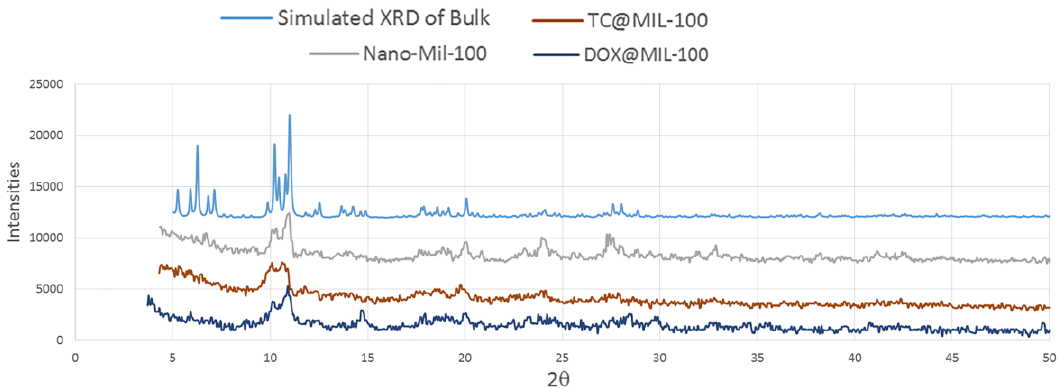
Figure 10. The XRD pattern of Simulated, Nano-MIL-100, TC@MIL-100, and DOX@MIL-100 (from top to bottom).